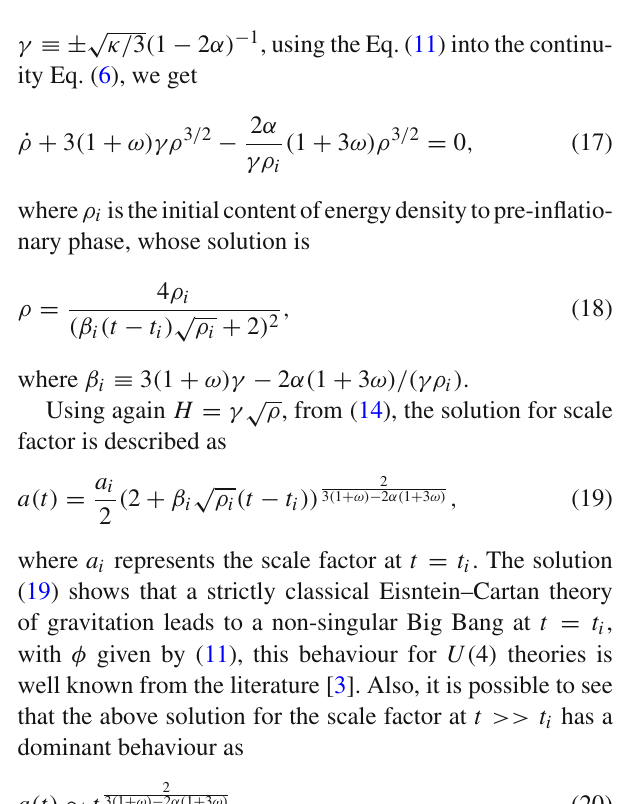
Fig. 1 Comparisonintheevolutionofthescalefactor a ( t ) fordifferent α values, whose parameters are negative and positive, in the inflationary